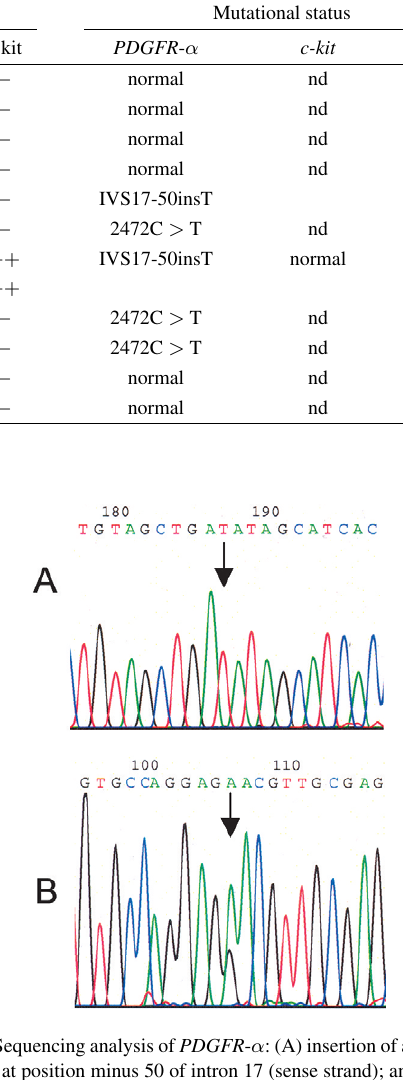
Fig. 1. Immunohistochemical expression of PDGF-A (A); PDGFR- α (B); SCF (C) and c-kit (D) in gliosarcomas (amplifica- tion: A–C, 200 × ; D, 400 × ).